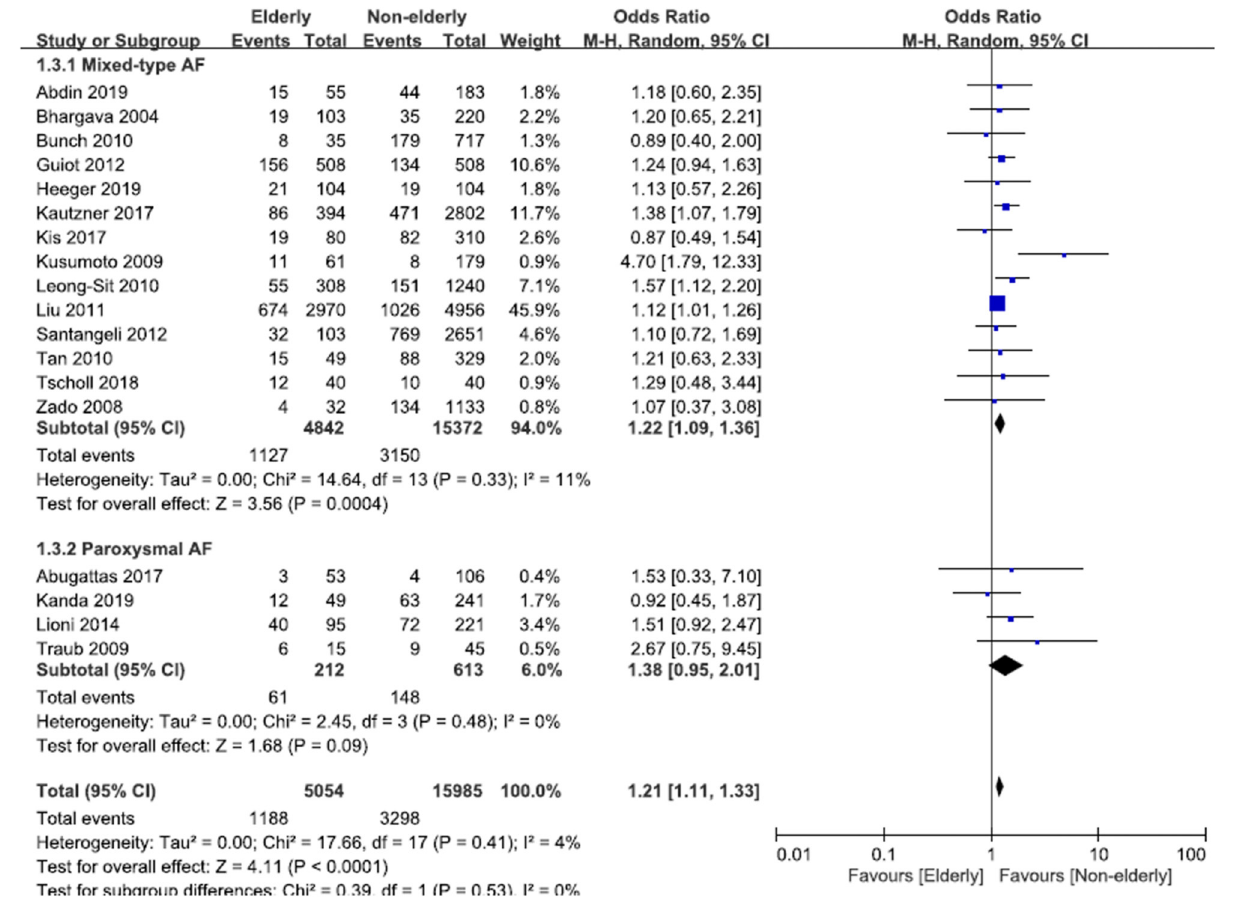
was 0.02 (95% CI, − 0.22–0.26; Figure 7B ), with